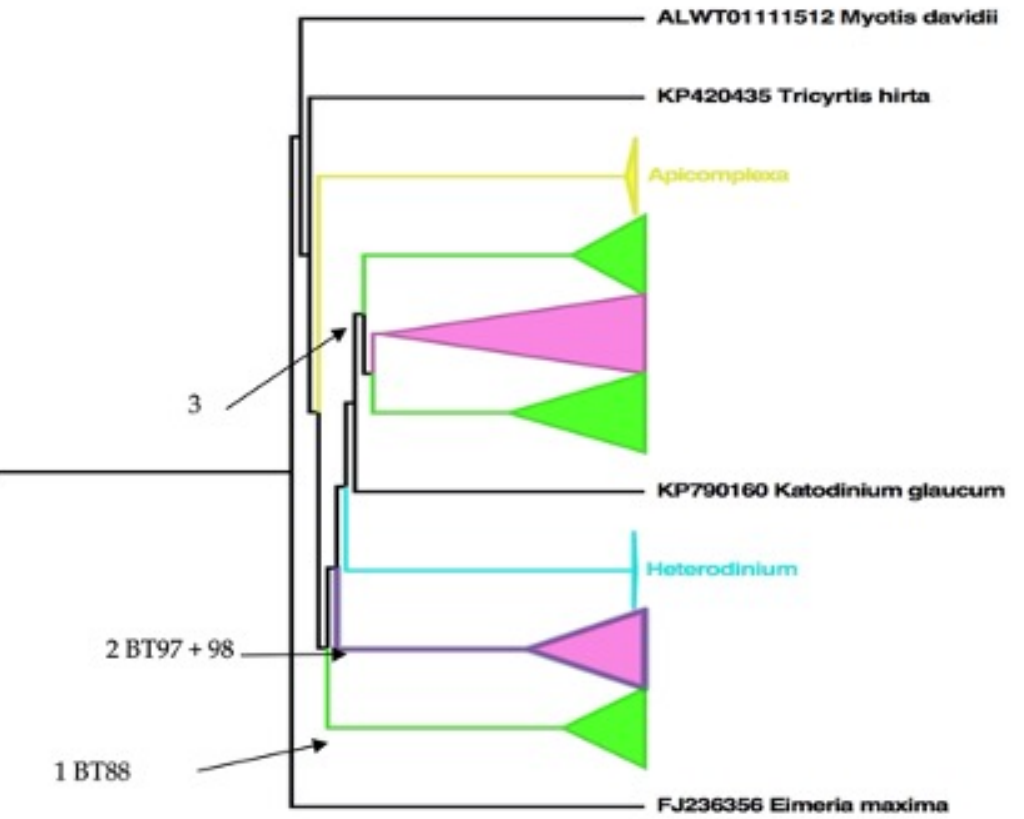
Figure 3. RAxML Bootstrap (BT) tree with clades closed to show the support for the major diver- gences in the tree. Clades 1–3 are discussed in